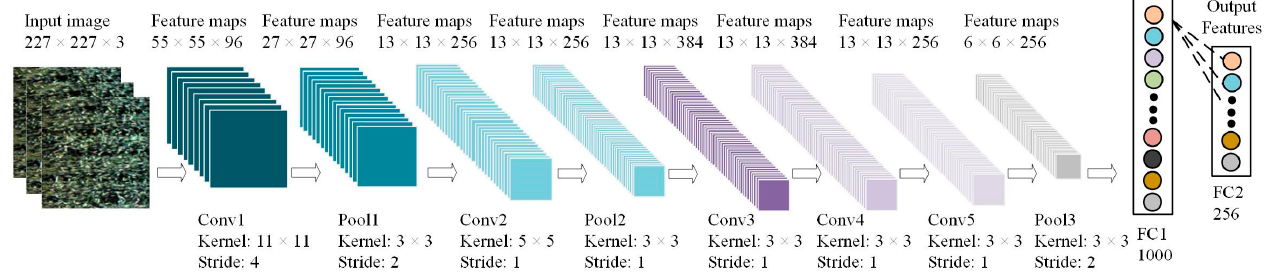
Figure 3. Convolutional neural network structure. Kernel represents the size of the convolution kernel (pixels), Stride represents the sliding step size, Conv1, Conv2, Conv3, Conv4, Conv5 represent the first, second, third, fourth, and fifth convolutional layers, and Pool1, Pool2, and Pool3 represent the first, second, and third pooling layer, FC1 and FC2 represent fully connected